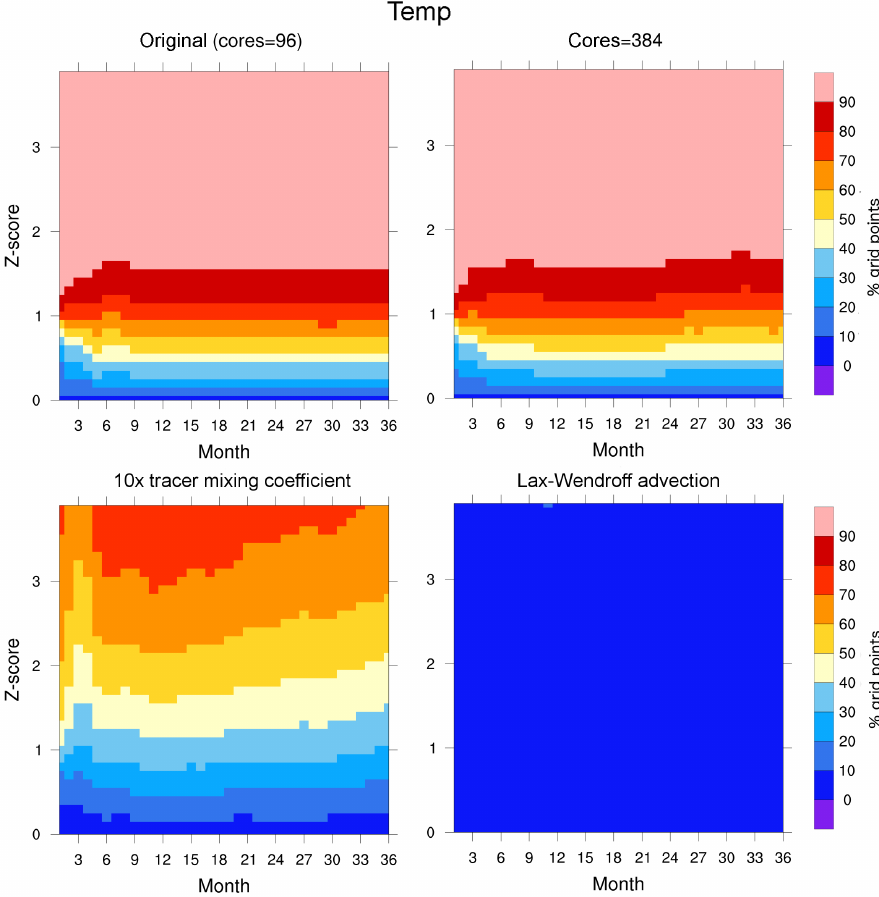
Figure 8. Response surfaces for Z -score of temperature (TEMP) over time (monthly) and Z -score threshold. The top two panels represent two different processor core layouts. The bottom left has a tracer mixing coefficient for convective instability that is 10 times larger than the original (100000.0), and the bottom right uses a different tracer advection scheme (Lax–Wendroff scheme with 1-D flux limiters). The color bar indicates the percentage of grid points with a Z -score below the Z -score tolerance (on the y